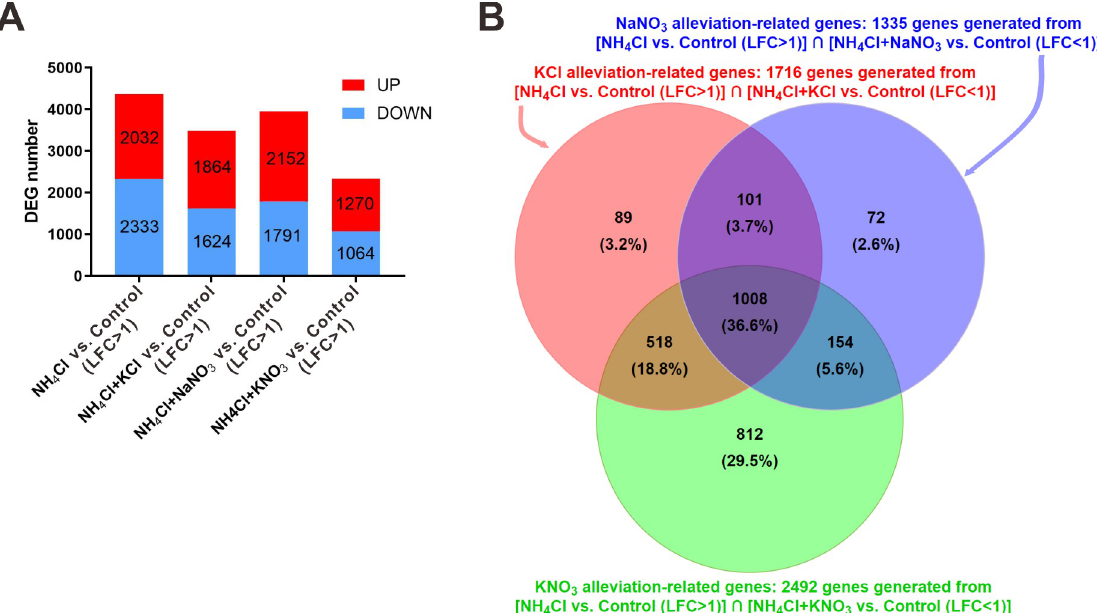
Fig 5. Differentially expressed genes (DEGs). (A) Numbers of differentially expressed genes between given treatments and the control (H 2 O). (B) Venn diagram showing alleviation-related gene numbers in each alleviation treatment. The expression of these genes was differentially regulated by ammonium toxicity and restored to the control level by the 3 alleviation